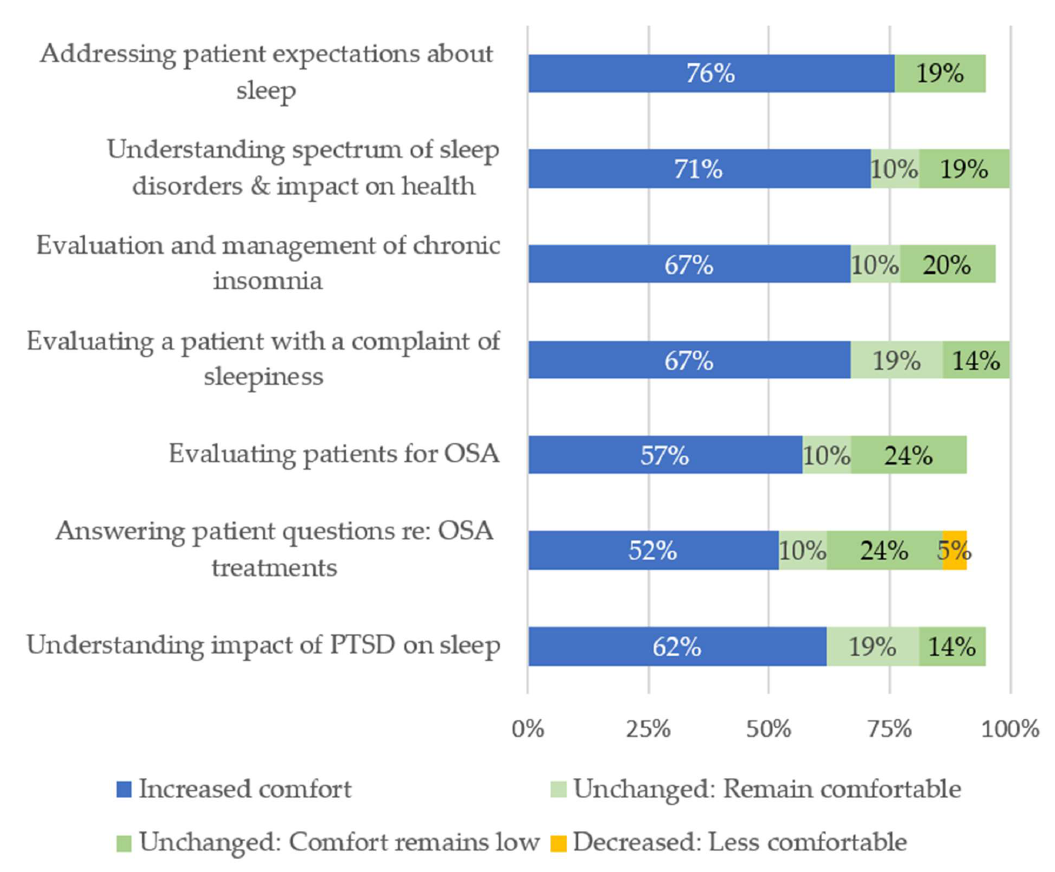
Figure 1. Self-reported change in comfort managing specific aspects of sleep care (n = 21). Abbreviations: OSA: obstructive sleep apnea; PSTD: post-traumatic stress disorder. Denominators include “not applicable” and “do not know” responses, but these categories are not displayed.